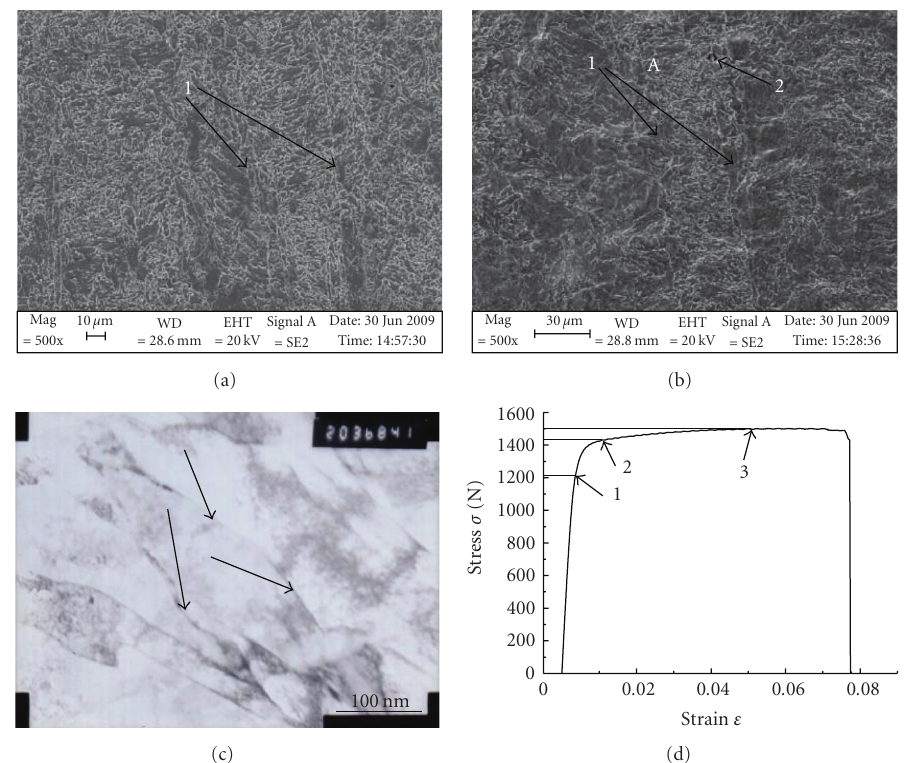
Figure 4: SEM and TEM pictures of granular bainite microstructure transformation (a) original, (b), and (c) after tensile, and (d) stress- strain curve.